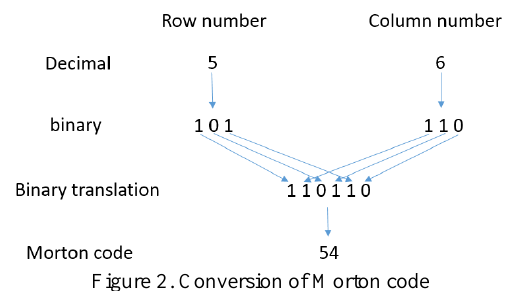
Figure 2. Conversion of Morton code